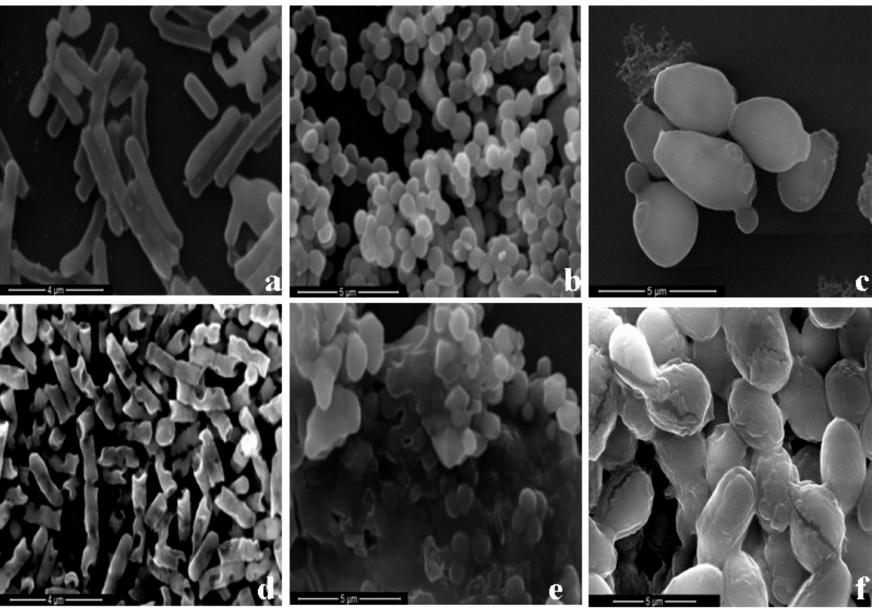
Figure 6. Scanning electron micrograph of 1 × 10 8 CFU/mL bacteria exposed to HJH-1 (1 × MIC). ( a ) Normal E. coli control. ( b ) Normal S. aureus . ( c ) Normal C. albican . ( d ) E. coli exposed to HJH-1. ( e ) S. aureus exposed to HJH-1. ( f ) C. albican exposed to HJH-1.